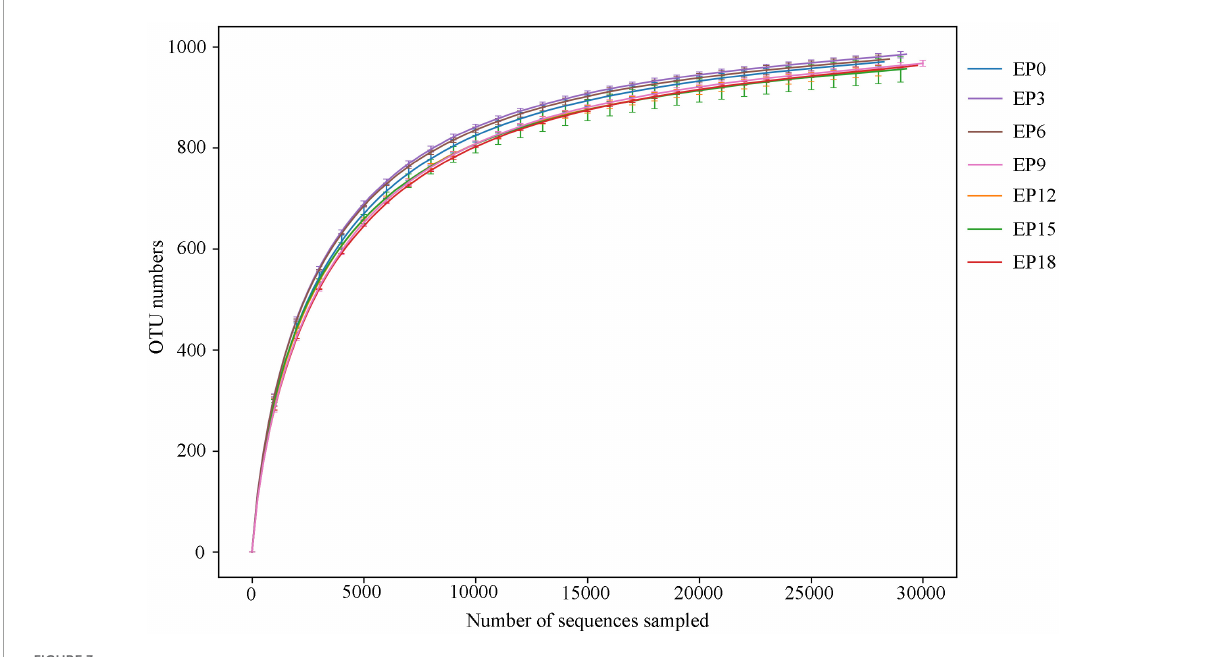
FIGURE3 Rarefaction curve of the intestinal microbiota in hybrid groupers fed with diets.